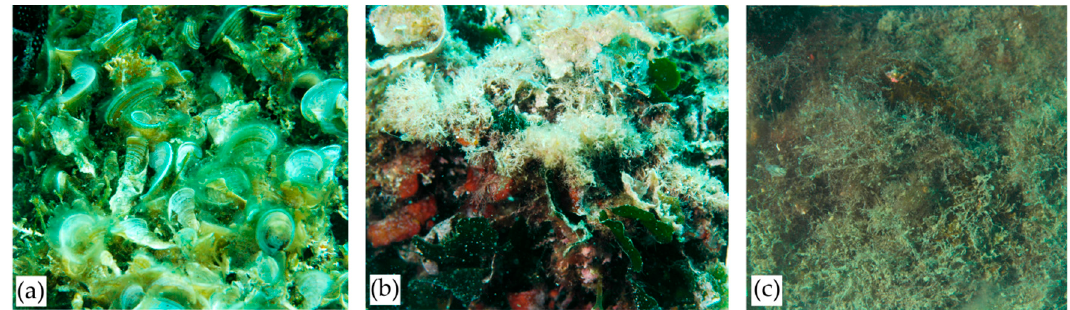
Figure 3. Representative algal assemblages at: ( a ) 1.5 m depth; ( b ) 5 m depth; ( c ) 25 m depth.